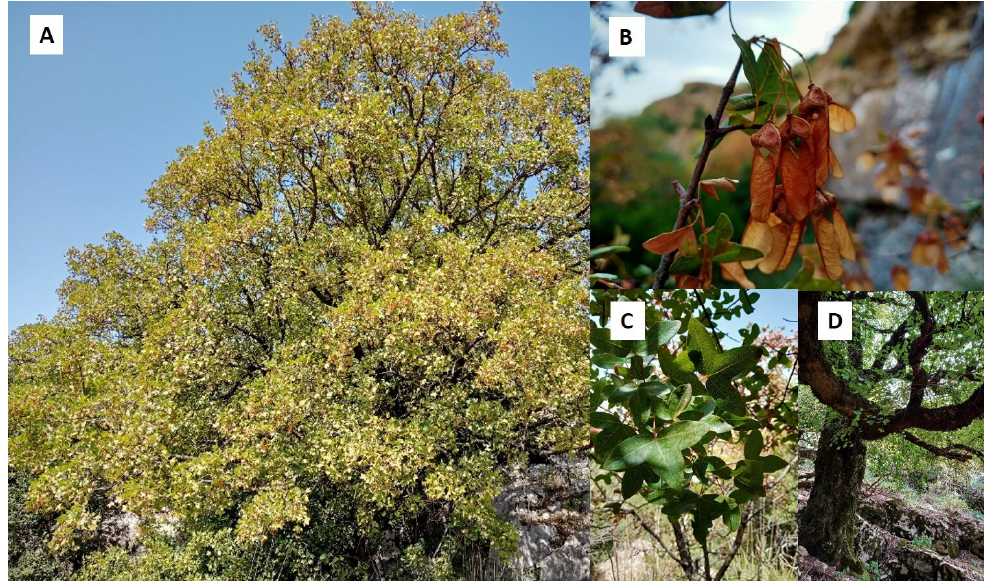
Figure 1. The Montpellier Maple ( Acer monspessulanum ) in its natural habitat: ( A ) whole tree; ( B ) samara fruits; ( C ) leaves; and ( D ) bark aspect. Photos were taken by Hamdi Aouinti in Djebel Serj, Tunisia.